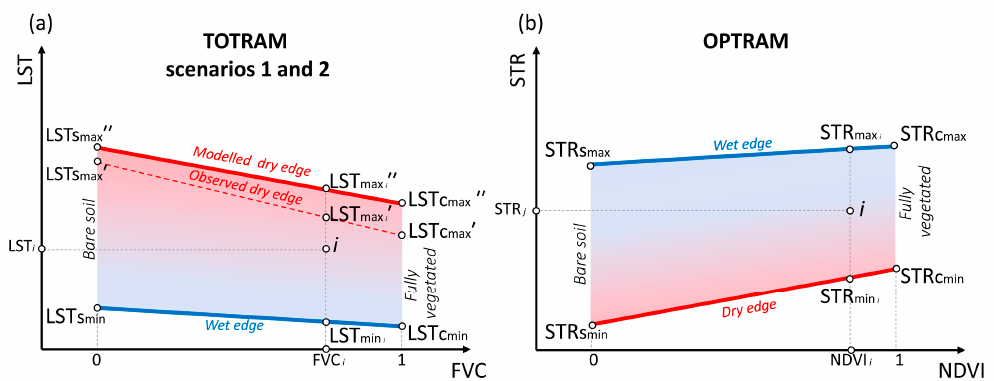
Figure 2. Illustration of the concept of: ( a ) the thermal-optical trapezoid models (TOTRAM); and ( b ) the optical trapezoid model (OPTRAM). LST is the land surface temperature, FVC is fractional vegetation cover, NDVI is the normalized difference vegetation index, and STR is the shortwave infrared transformed reflectance. For TOTRAM, both the observed (Scenario 1) and the modeled (Scenario 2) dry edges are presented. The dry edges are indicated by points LSTs max ׳ and LSTc max ׳ for TOTRAM Scenario 1, LSTs max ׳׳ and LSTc max ׳׳ for TOTRAM Scenario 2, and STRs min and STRc min for OPTRAM. The wet edges are indicated by points LSTs min and LSTc min for both TOTRAM scenarios, and STRs max and STRc max for OPTRAM. The color gradient shows the soil moisture availability from blue (wet edge) to red (dry edge). Point i is a surface with LST i , FVC i , STR i , and NDVI i . For i within LST-FVC space, the temperature of wet edge is LST min,i , observed dry edge is LST max,i ׳ , and modeled dry edge is LST max,i ׳׳ . For i within STR – NDVI space, the STR value for the wet and dry edge are STR max,i and STR min,i , respectively.